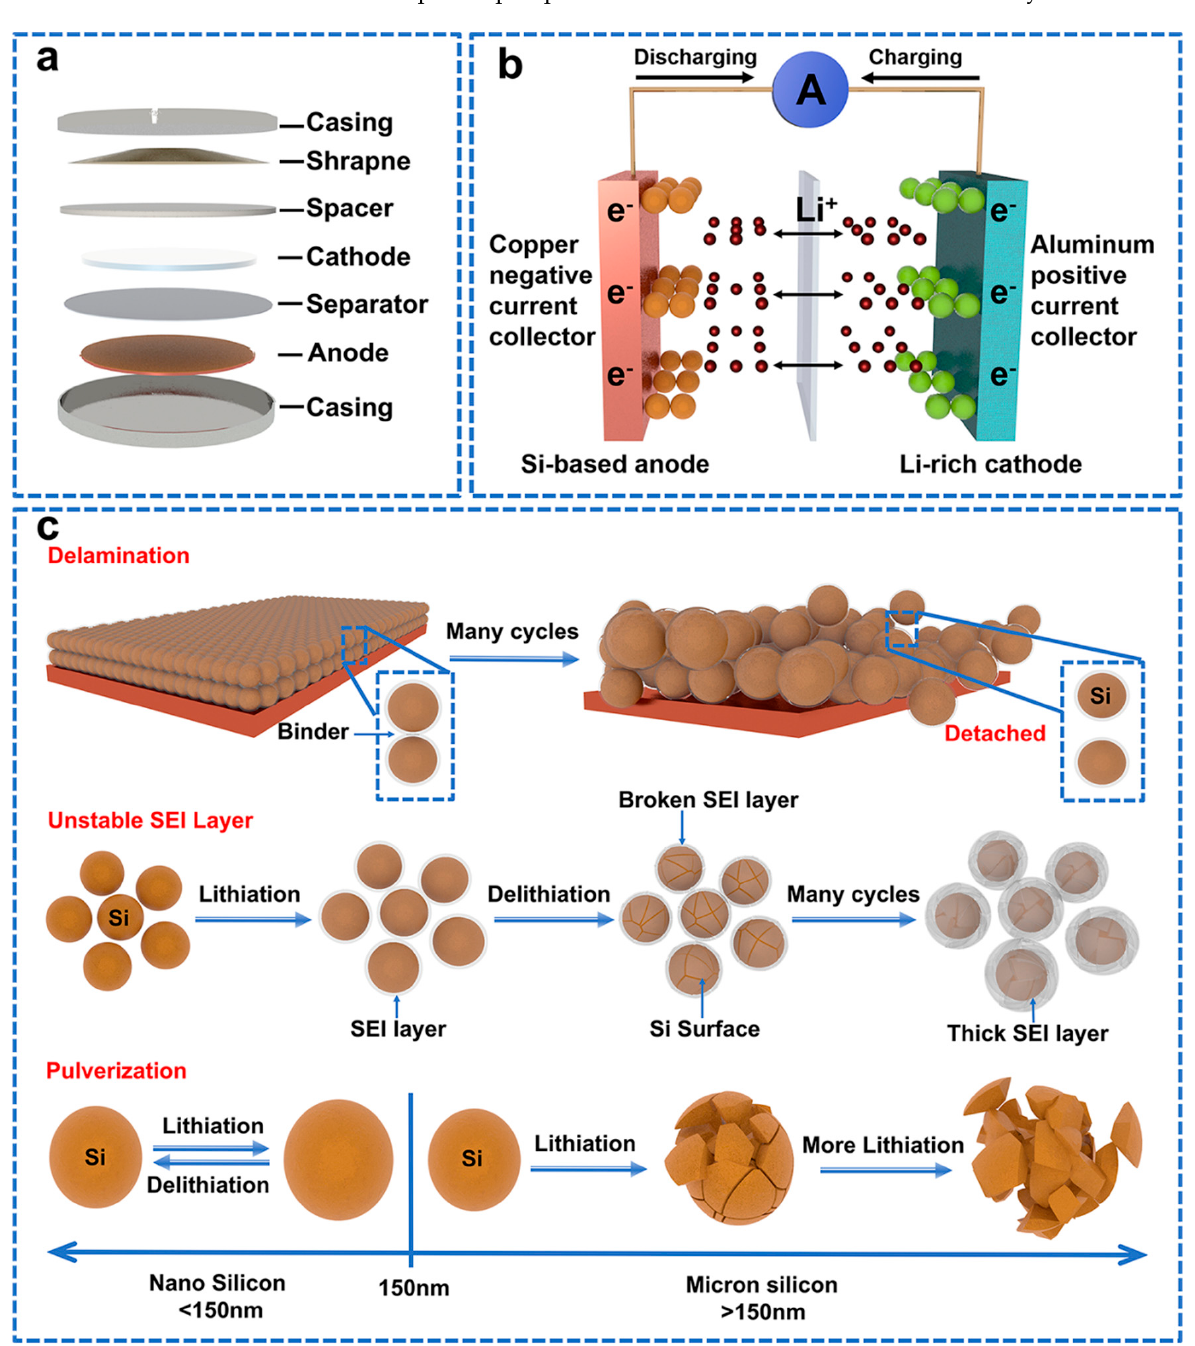
Figure 1. ( a ) Diagram of lithium − ion button battery. ( b ) Schematic diagram of lithium − ion Si − anode battery. ( c ) Three representative failure mechanisms of Si anodes: delamination, unstable SEI layer, and pulverization [24].